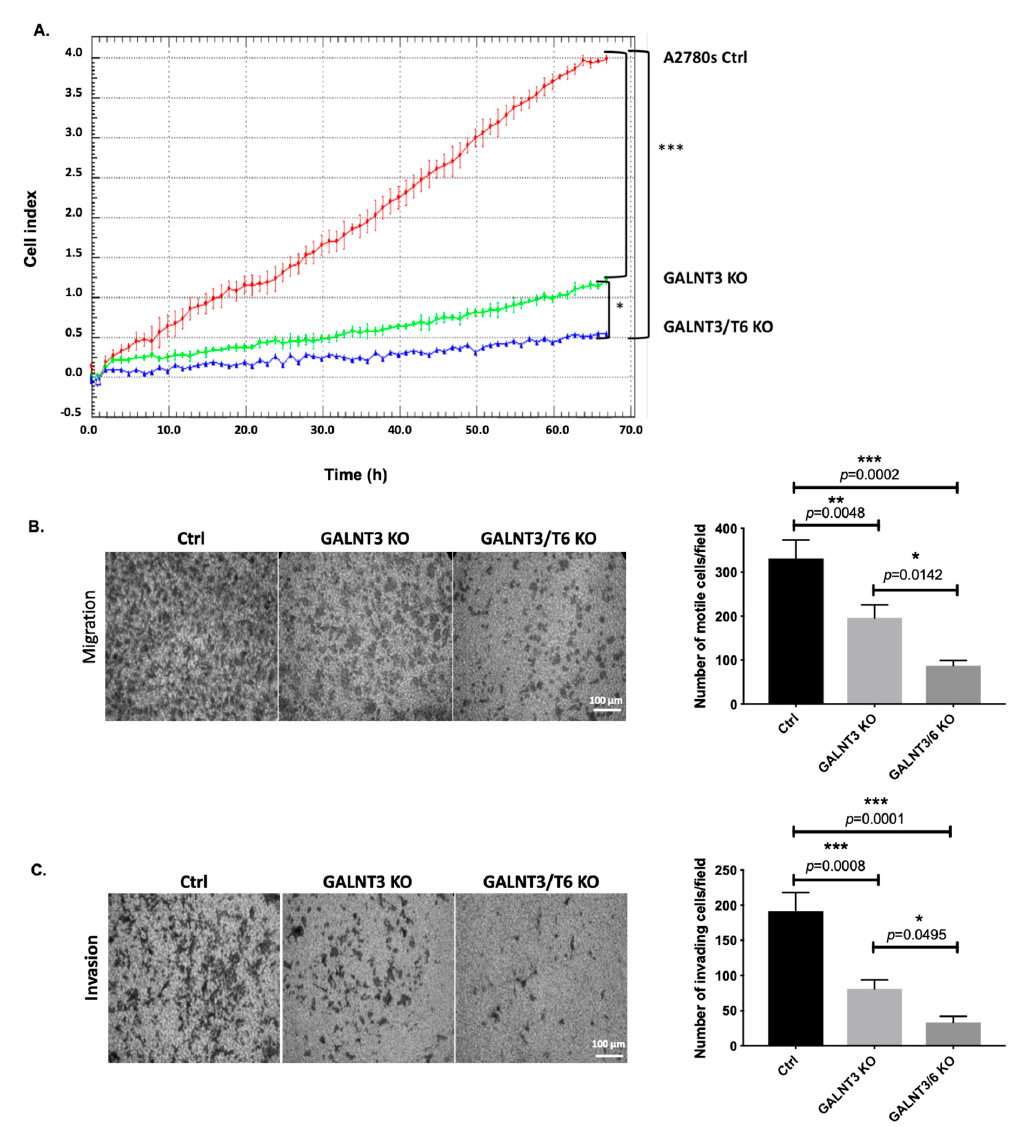
Figure 3. E ff ect of the GALNT3 KO and the double GALNT3 / T6 KO on A2780s cell proliferation, migration and invasion. ( A ) Cell proliferation of GALNT3 KO and GALNT3 / T6 KO clones compared with the control clone (Ctrl). Cell index refers to a relative change in electrical impedance representing the number of cells detected on the microelectrodes on the bottom of the xCELLigence wells. ( B ) Cell migration of GALNT3 KO and GALNT3/T6 KO clones compared with the control clone (Ctrl) (scale bar 100 μ m). ( C ) Cell invasion of GALNT3 KO and GALNT3/T6 KO clones, as compared with the control clone (Ctrl) (scale bar 100 μ m). The corresponding histograms represent quantitative determinations of migration and invasion data obtained by selecting 10 random fields per filter under phase contrast microscopy; results are expressed as number of cell changes (migration and invasion) of GALNT3 KO and GALNT3/T6 KO clones compared with the control clone (Ctrl) ( n = 3). Data are presented as mean ± SEM and were analyzed by one-way ANOVA followed by a Dunnett’s test for multiple comparisons. A significant association was considered when p -values were < 0.05. GraphPad style was used for p -value presentation; p -value symbols refer as follows: ns p > 0.05, * p ≤ 0.05, ** p ≤ 0.01, *** p ≤ 0.001, **** p ≤